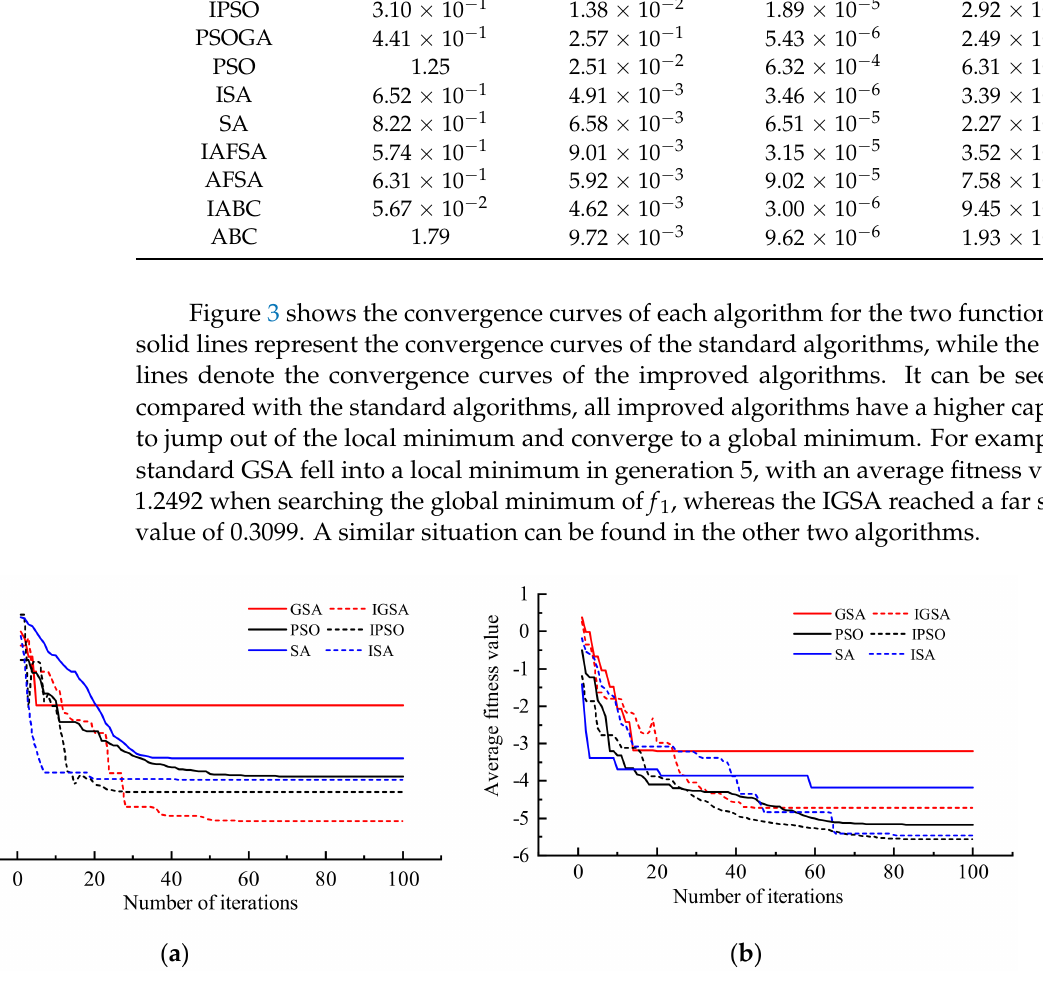
Figure 3. The convergence curves of each algorithm for the two functions: ( a ) f 1 ; and ( b ) f 2